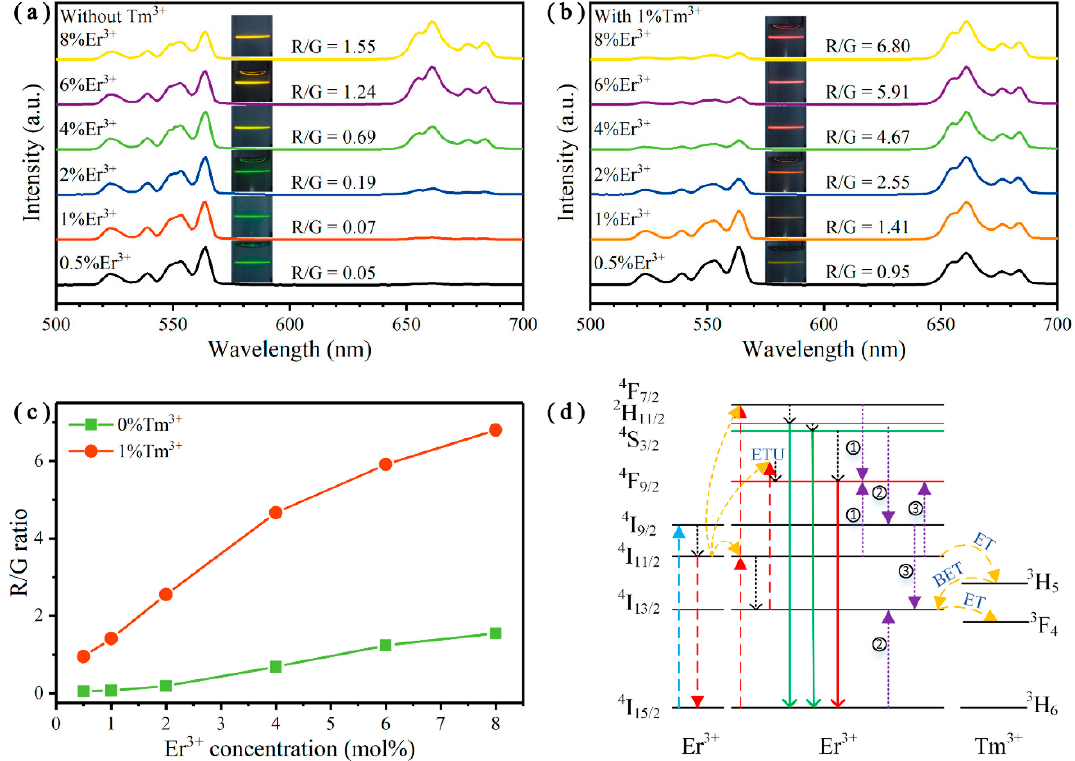
Figure 7. Normalized UC emission spectra of Y 2 O 3 :Er 3+ /Tm 3+ ( x / y mol%) UCNPs, x = 0.5, 1, 2, 4, 6, 8, ( a ) y = 0, ( b ) y = 1. ( c ) R/G ratios of the Y 2 O 3 :Er 3+ /Tm 3+ UCNPs doped with different concentrations of Er 3+ and Tm 3+ ions. ( d ) ET and BET mechanism between Er 3+ and Tm 3+ ions. All excited by an 808 nm laser at an excitation intensity of 297 W cm − 2 .